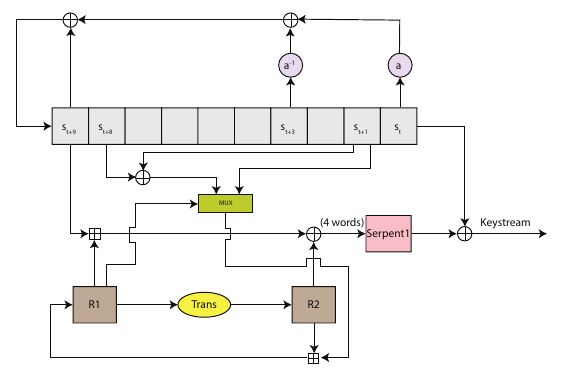
Figure 7: An overview of the Sosemanuk stream